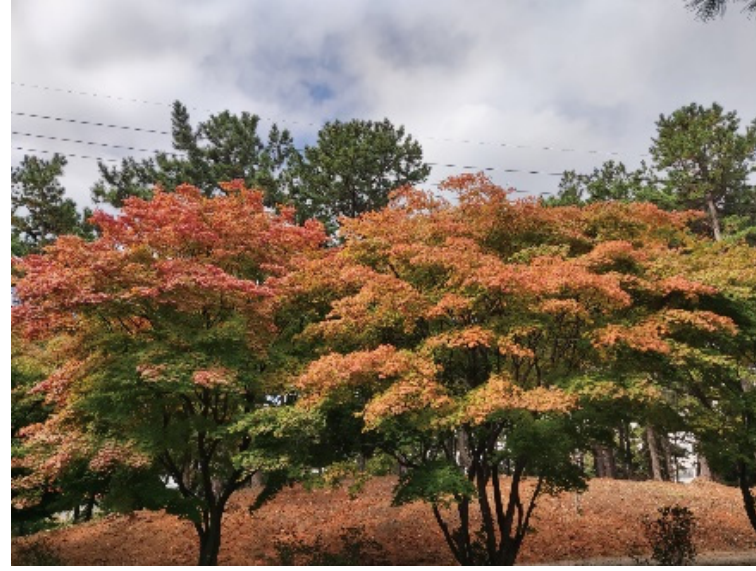
Figure 1. Maple leaves of different colors in Jeonju University.